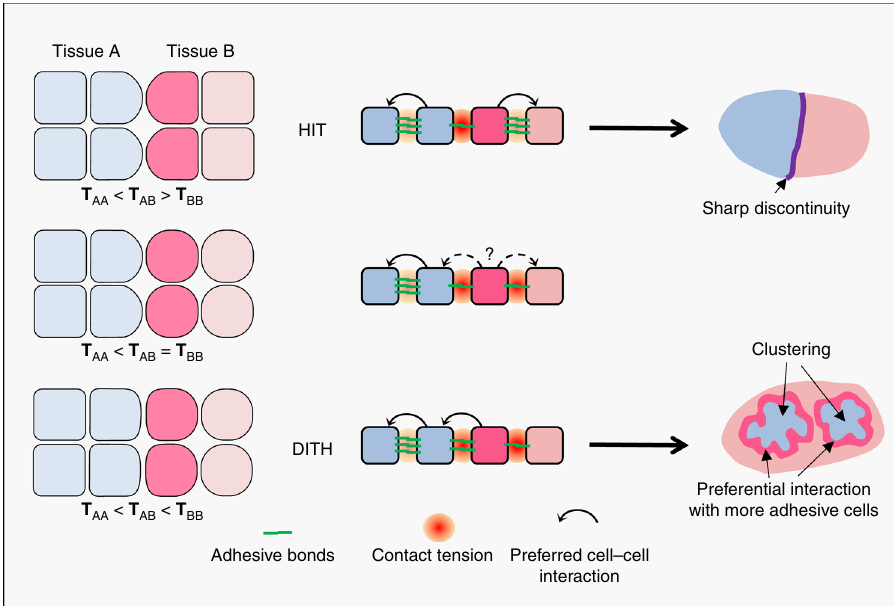
Fig. 8 Summary diagram comparing HIT and DITH situations. Two cell types A and B are represented in blue and pink . B-type cells abutting A-type cells are in darker pink . In a HIT situation ( top ), where heterotypic contact tension T AB is higher than the two homotypic tensions, cells tend to establish more stable contacts with sibling cells of the same type. At the tissue scale, this drives full segregation of the two cell populations separated by a sharp boundary. In a classical DITH situation ( bottom ), blue A-type cells will be able to cluster, but for dark pink B-type cells, heterotypic contacts may be more stable than homotypic contacts, thus these cells will tend to preferentially interact with the less tensile/more adhesive A-type cells, a situation that will not lead to clean segregation of the two cell populations. The middle row illustrates an intermediate situation, where separation may still be achieved provided a suf fi ciently strong difference between T AB and T